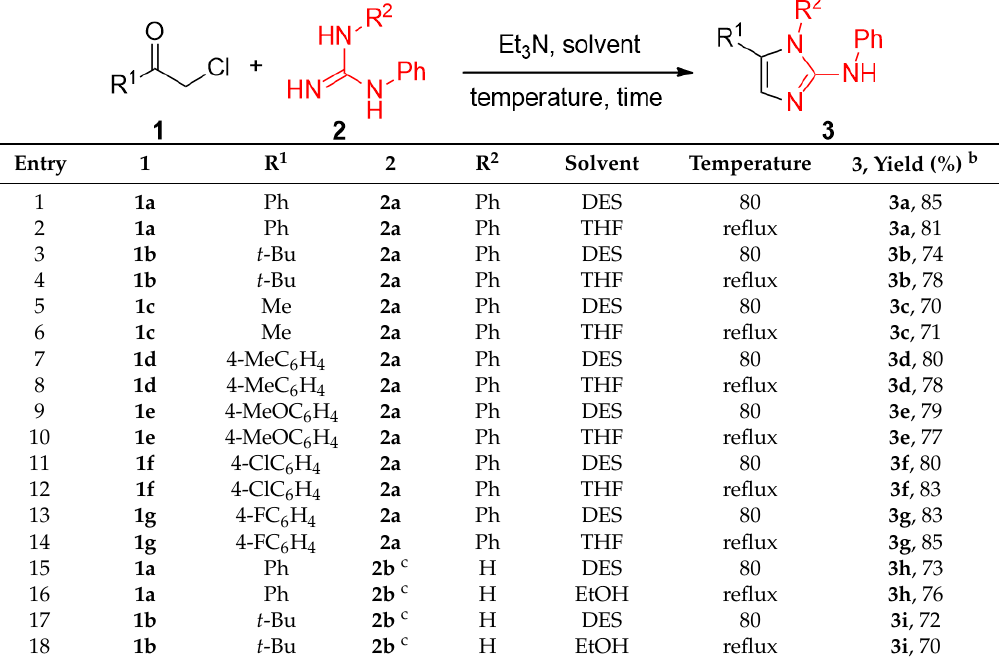
Molecules 2016 , 21 , 924